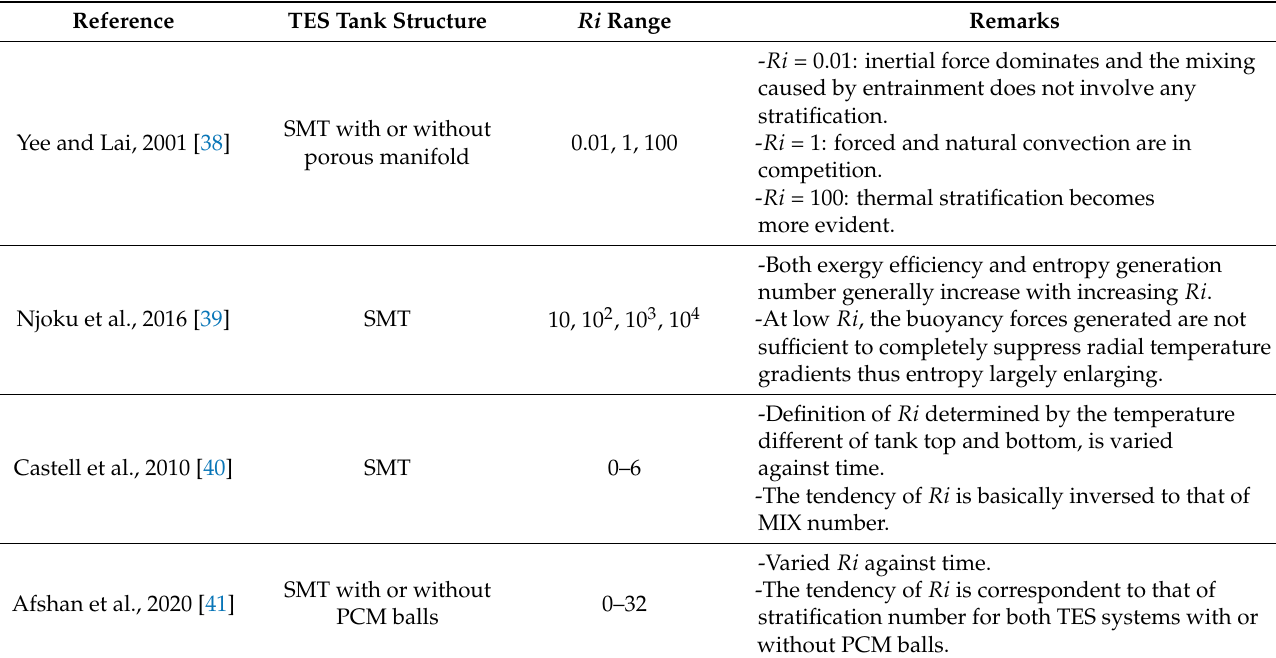
Table 2. Comments on the bulk Richardson number for indicating the thermal stratification